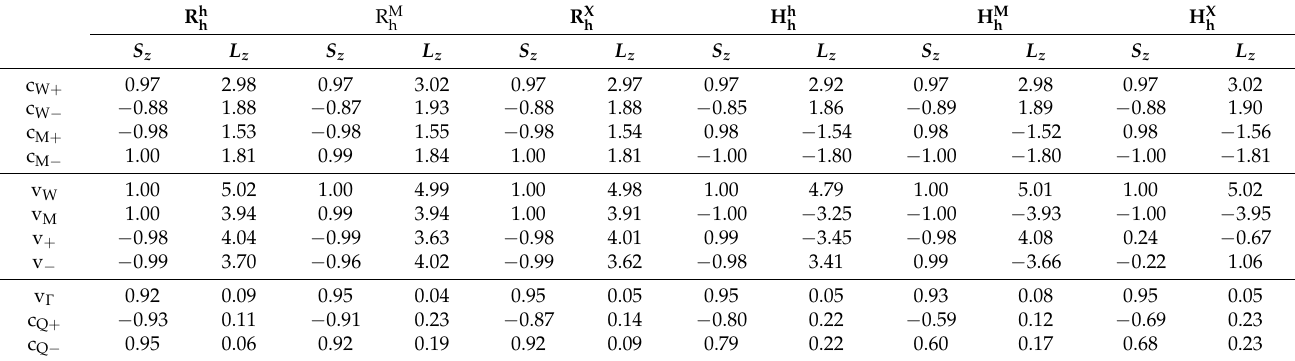
Table 4. Calculated values of S z and L z for the relevant energy bands in R- and H- type stackings. R h h